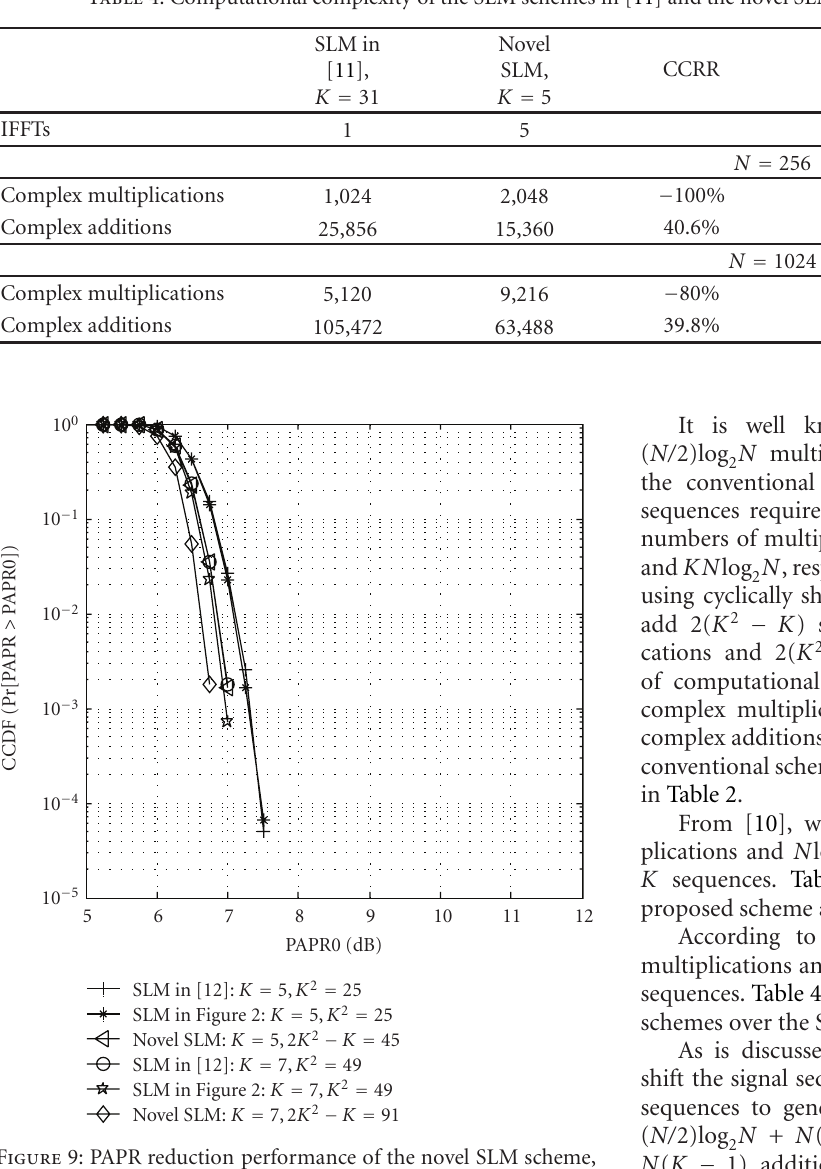
Figure 9: PAPR reduction performance of the novel SLM scheme, SLM scheme in Figure 3, and the SLM scheme in